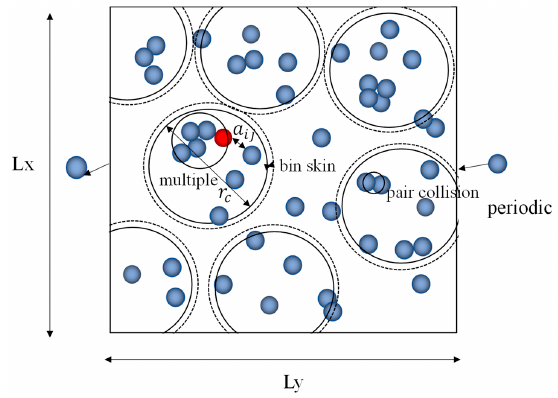
Figure 1. Neighbor list and collision progress.